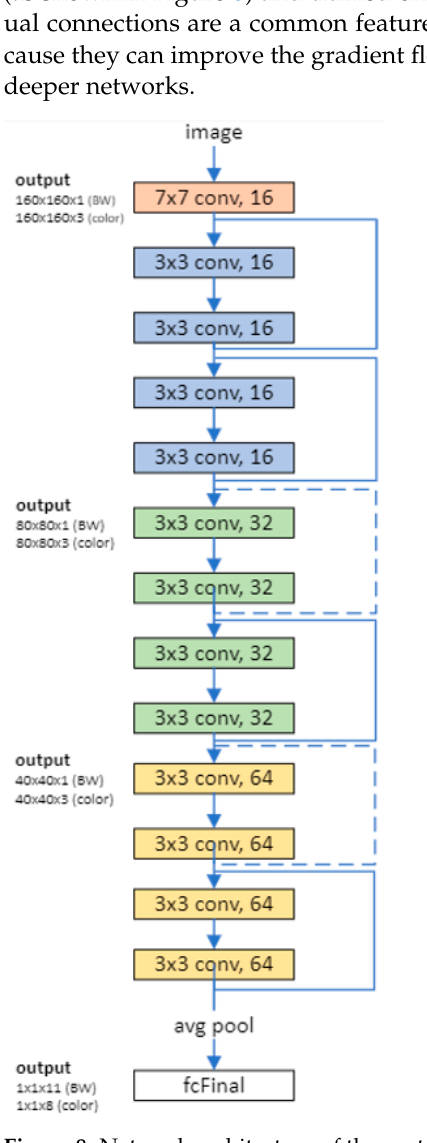
Figure 8. Network architecture of the customized residual network. The dotted shortcuts increase dimensions. Kernel input of the first layer can be modified into [7 × 7], [5 × 5], or [3 × 3]. Refer to Table 9 for the residual model’s architecture.